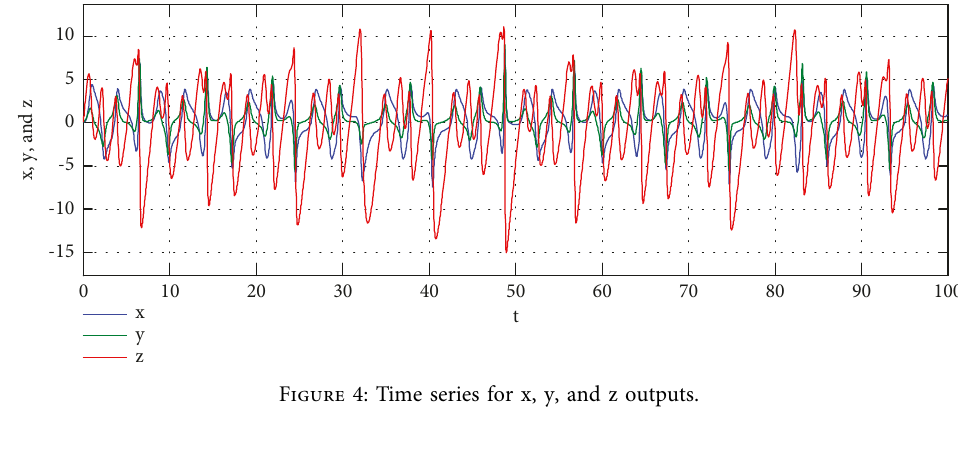
Figure 4: Time series for x, y, and z